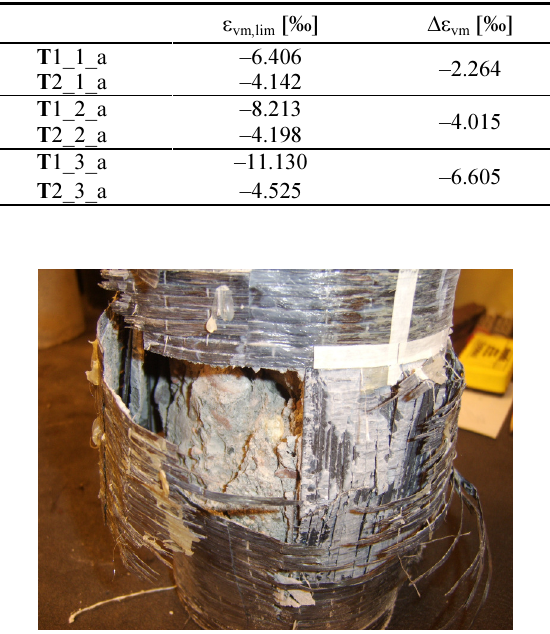
Table 6. The comparison of the longitudinal limit strains of the